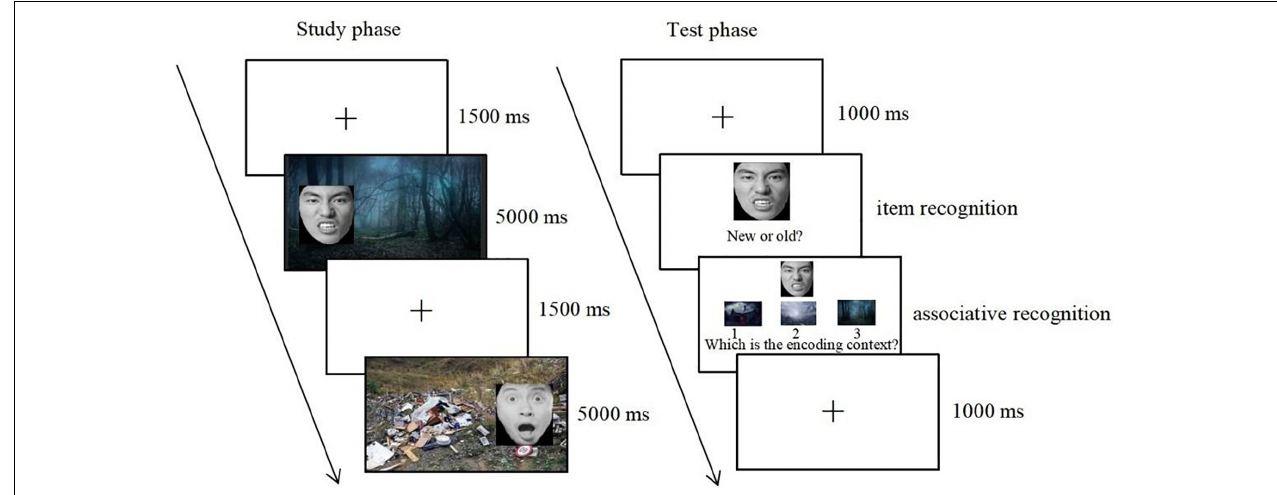
FIGURE 1 | The procedure for the study phase and the test phase. Copyright: Chinese Facial Affective Picture System (Gong et al., 2011), republished with